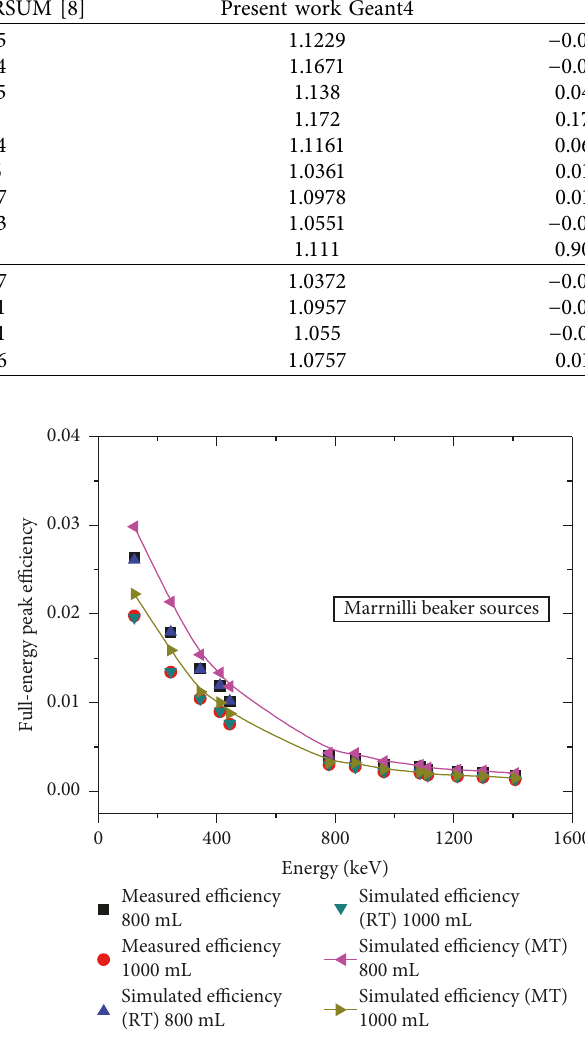
Table 4: Comparison between the present work and the modified KORSUM code and the deviation error between them. Decay